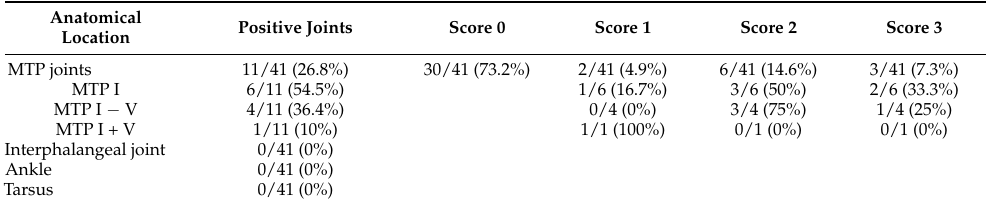
Table 2. Scoring of MSU deposits in foot joints of embalmed cadavers.